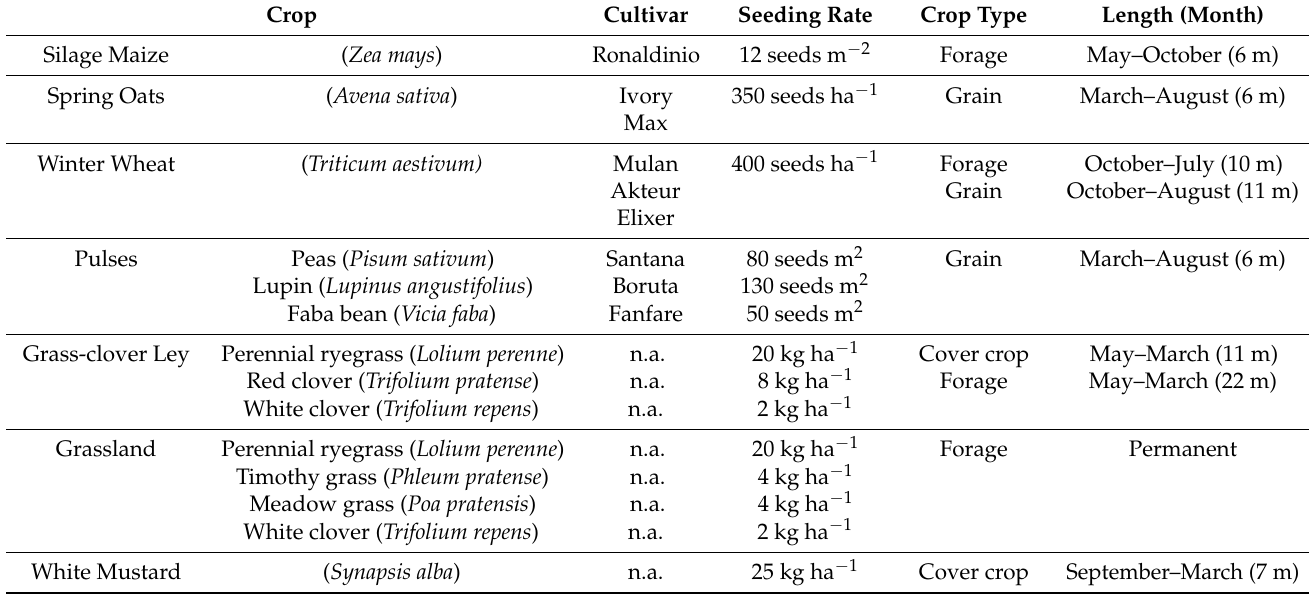
Table 1. Seed mixtures, cultivars, seeding rates, and crop type-dependent duration in months. Crop Cultivar Seeding Rate Crop